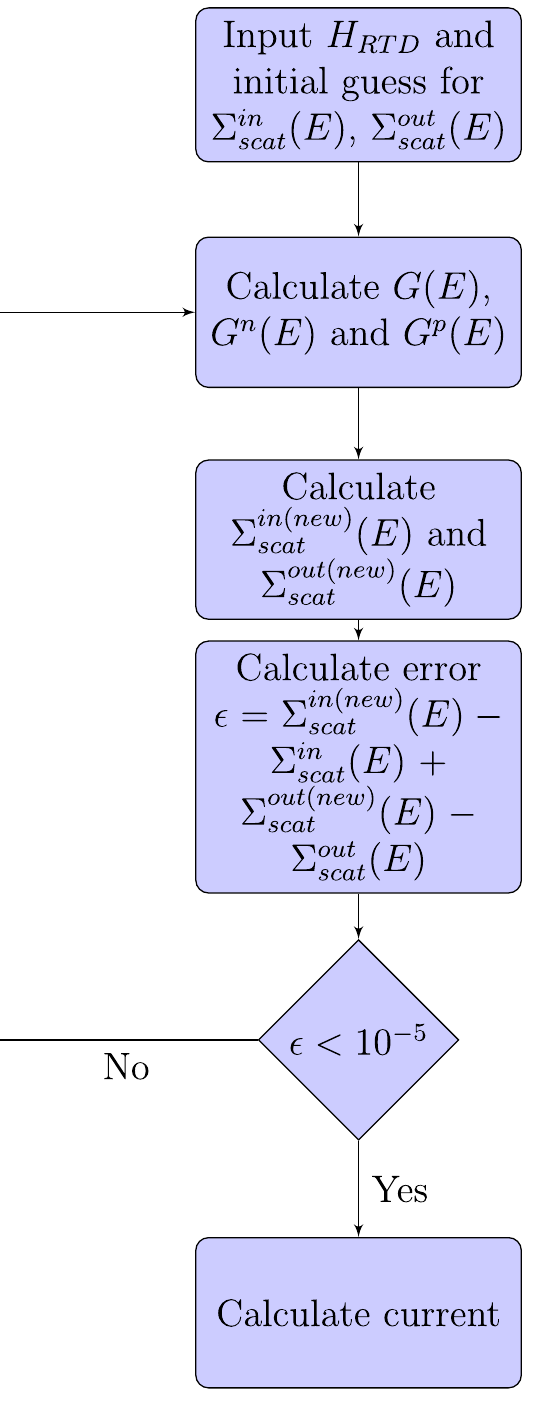
Figure 6. Algorithm for calculating the current using the NEGF method within the self-consistent Born